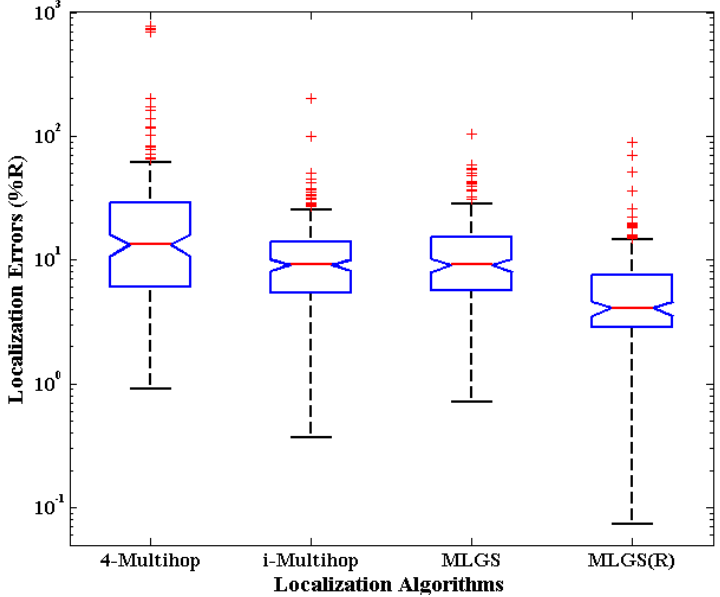
Figure 10. Distribution boxplots of node localization errors (isotropic network).